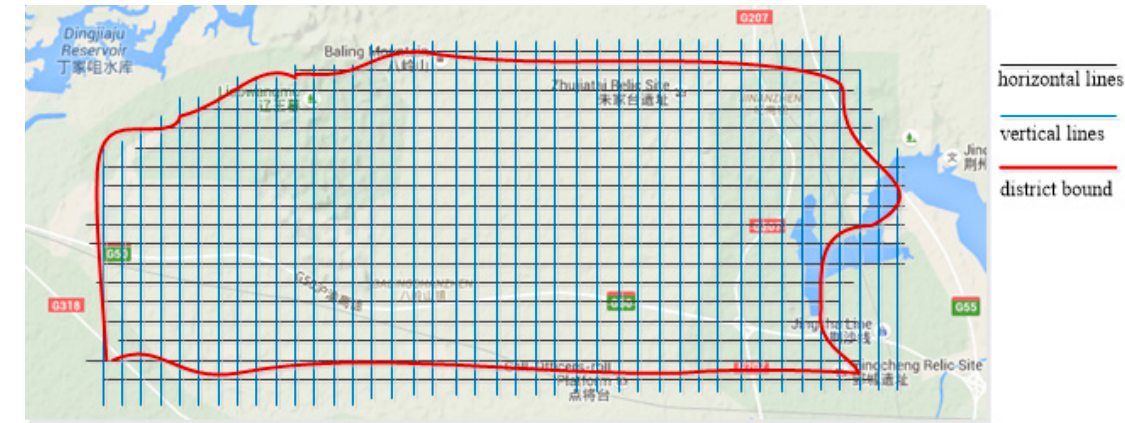
Figure 5. Light Detection and Ranging (LiDAR) data collection flight grid for obtaining a high-density point cloud.